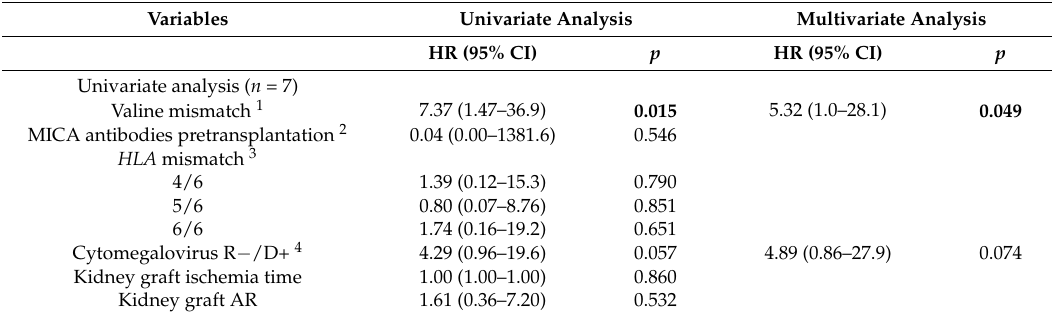
Table 2. Univariate and multivariate Cox regression analysis of individual covariates and their impact on the risk of cytomegalovirus infection.